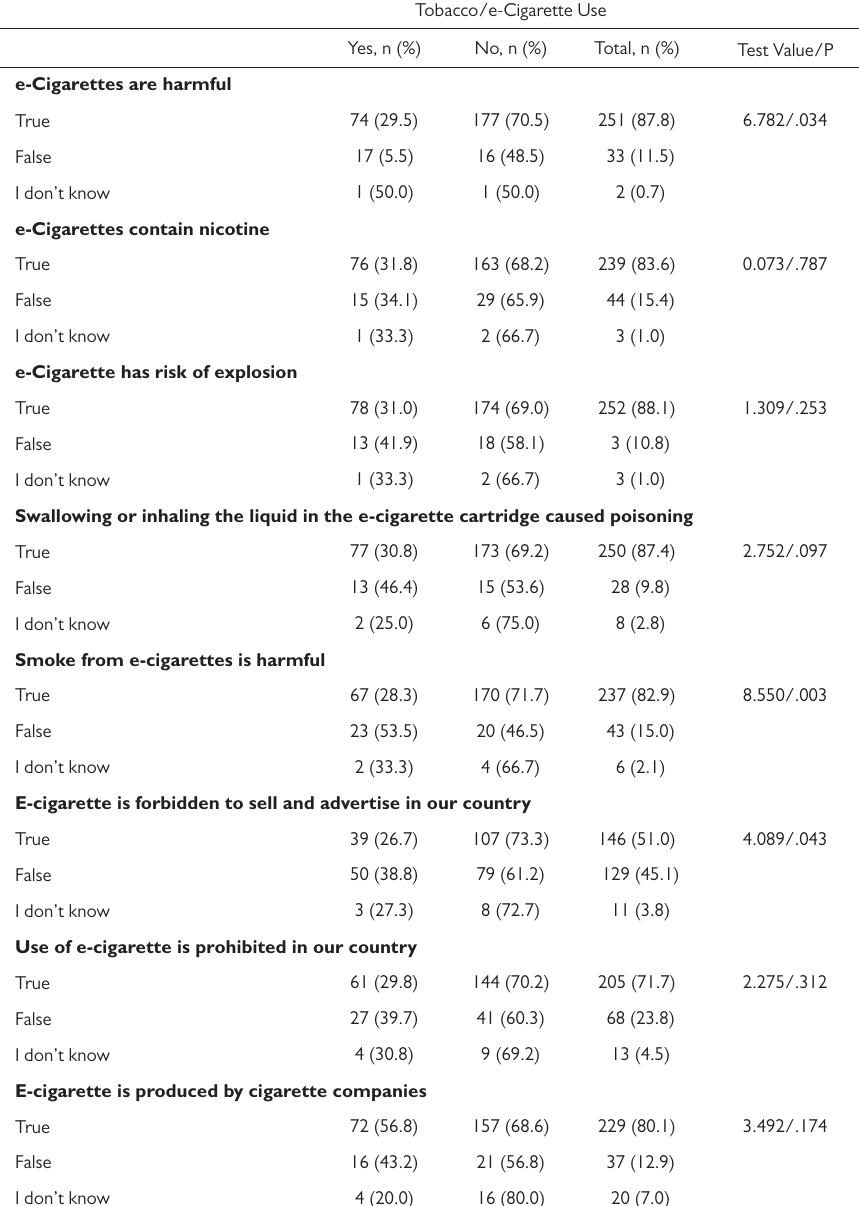
Table 3. Opinions According to Tobacco/e-Cigarette